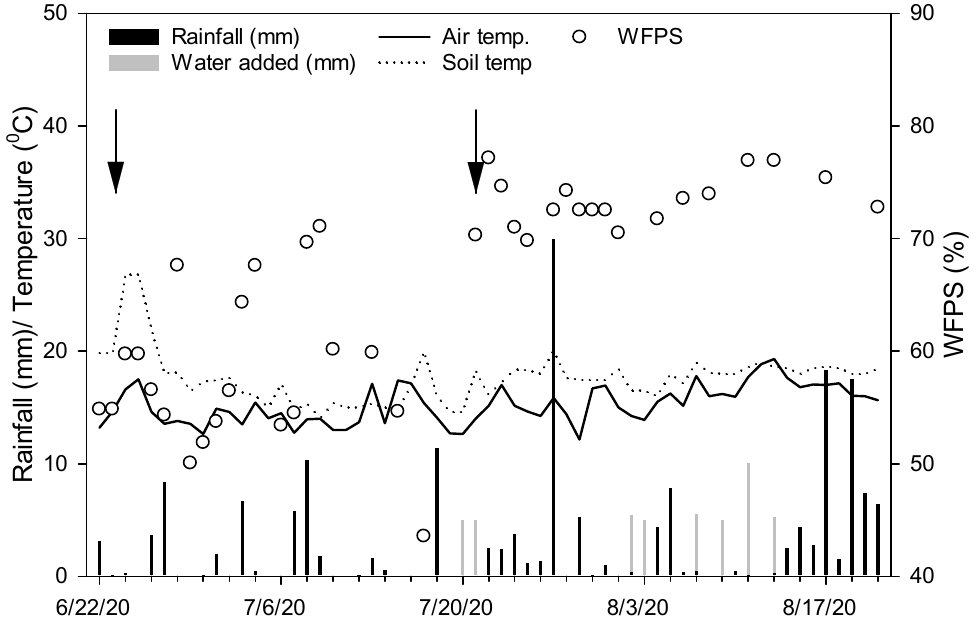
Figure 2. Average air and soil (5 cm depth) temperature, rainfall and water filled pore space (WFPS) over the measurement period. Grey bars represent the amount of additional water applied by hand. Arrows indicate application dates of fertilisers.